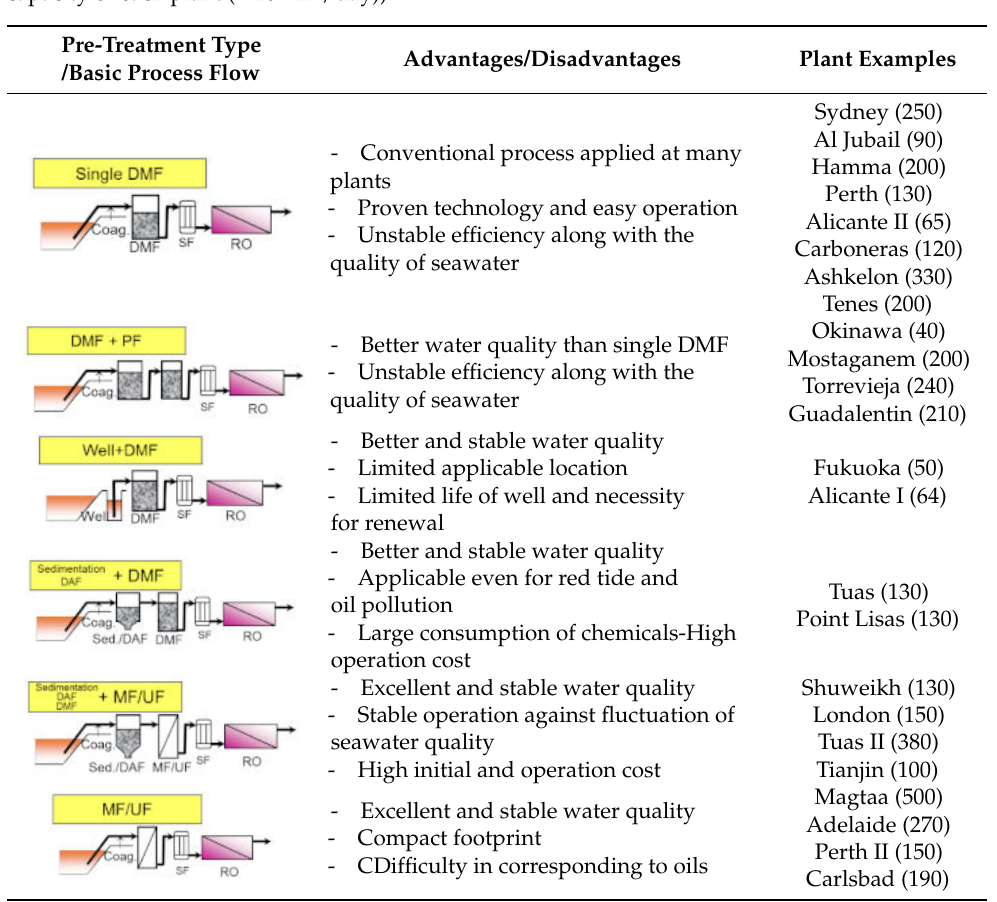
Table 2. The typical pre-treatment types and their basic pre-treatment process flow configurations. Their main advantages and disadvantages are also summarized with example desalination plants that have adopted these pre-treatment processes (plant information was summarized with referring yearbooks published from IDA [21–27] and the parenthesized values indicate the product water capacity of each plant ( × 10 3 m 3